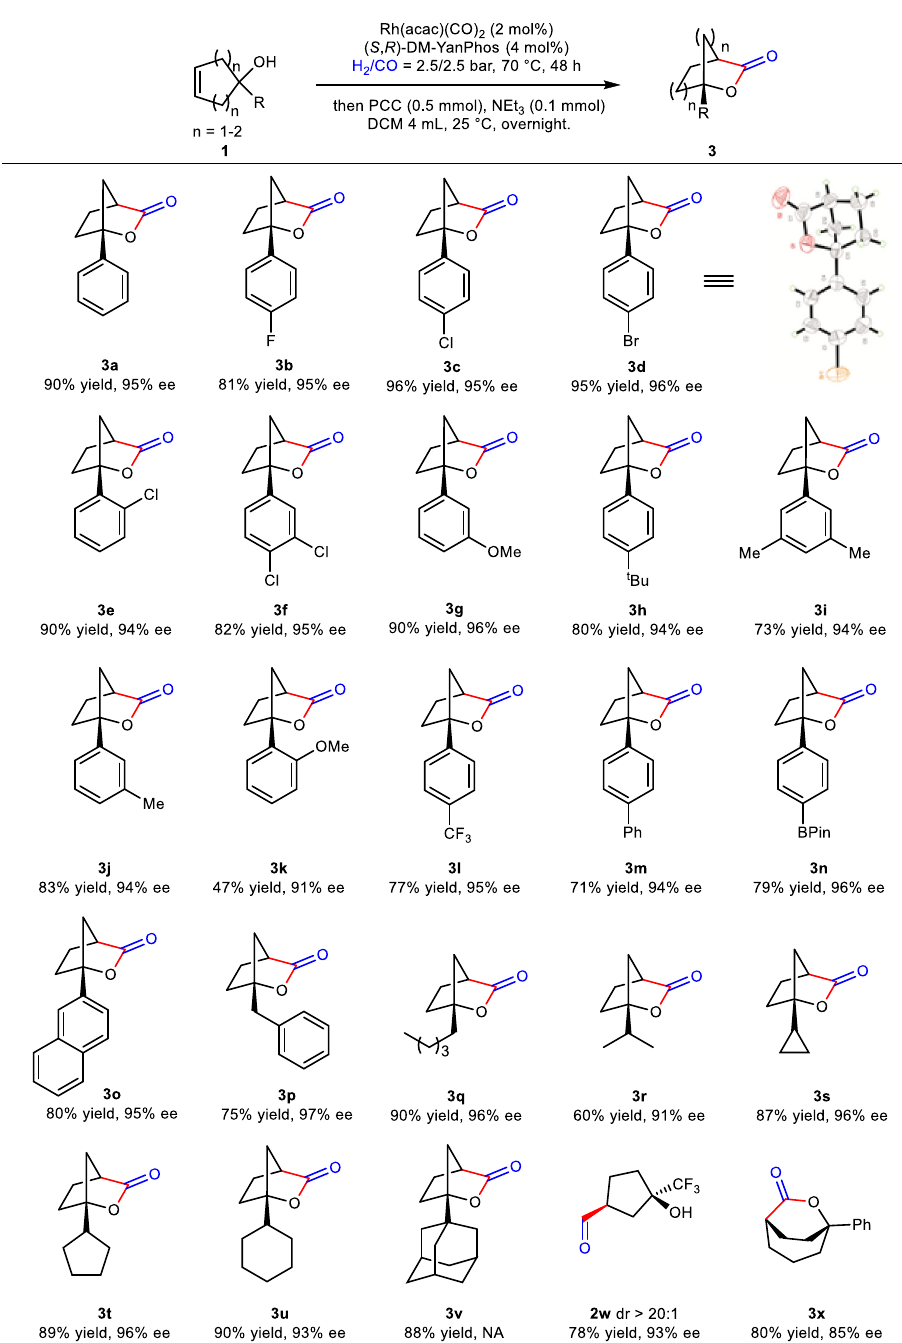
Fig. 4 Scope of 1-substituted cyclopent-3-en-1-ols and 1-phenylcyclohept-4-en-1-ol. Reaction conditions: The reaction of 1a (0.2 mmol) was performed in the presence of Rh(acac)(CO) 2 (2 mol%), L11 (4 mol%), H 2 /CO = 2.5/2.5bar in toluene (1 mL) at 70 °C for 48 h, The reaction was cooled to room temperature and the pressure was carefully released in a well-ventilated hood, then the mixture was treated with PCC (0.5 mmol), Et 3 N (0.1 mmol) in DCM (4 mL) at 25 °C, overnight. NA = not